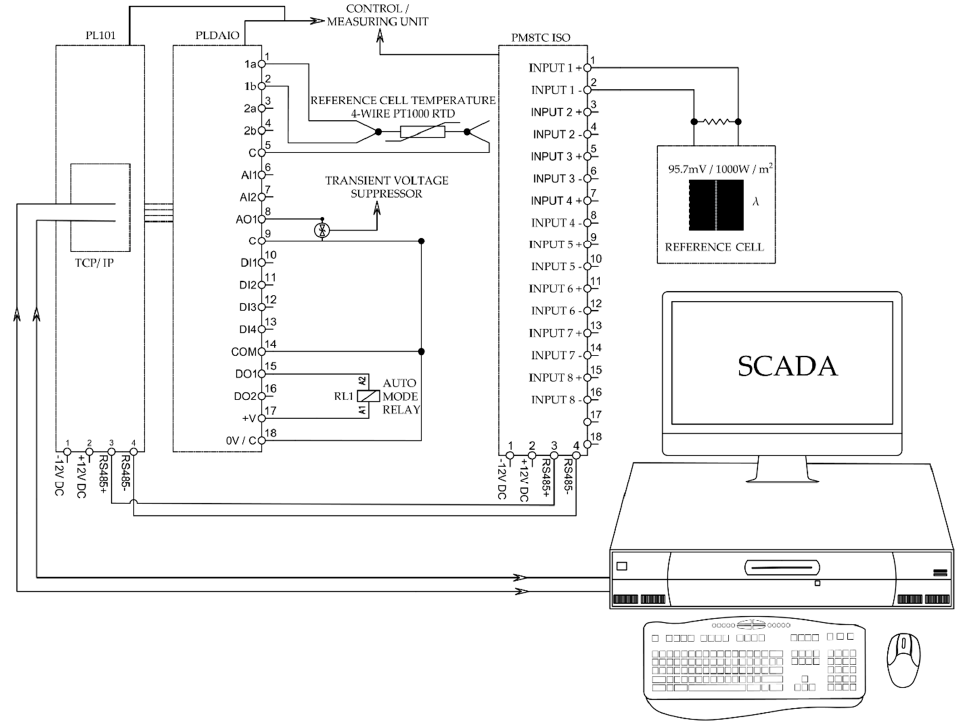
Figure 1. Schematic diagram of the autonomous dynamic adaptability system (ADAS).